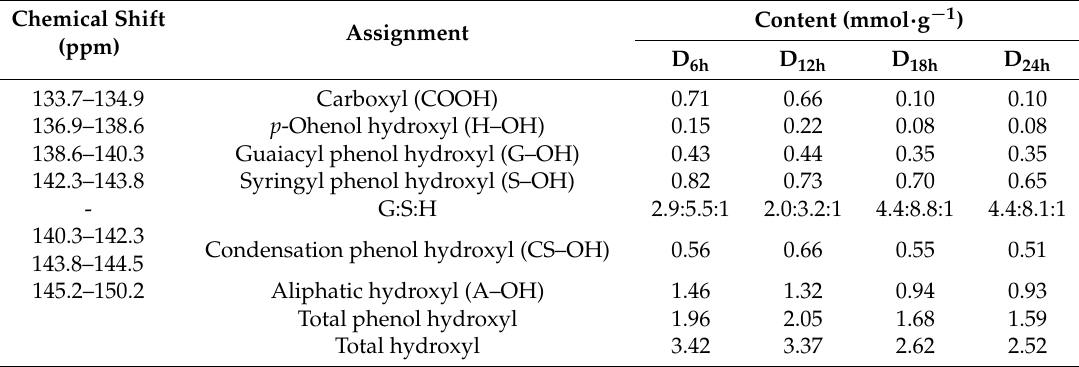
Figure 3. Quantification of different hydroxyl group (A–OH: aliphatic hydroxyl; G–OH: guaiacyl phenol hydroxyl; S–OH: syringyl phenol hydroxyl; H–OH: p -phenol hydroxyl; CS–OH: condensation phenol hydroxyl; COOH: carboxyl) contents (mmol/g) of DES-lignin samples (D 6h , D 12h , D 18h , D 24h ) extracted from willow by DES treatment at 120 ◦ C for 6, 12, 18, and 24 h as determined by 31 P NMR. Table 5. 31 P NMR analysis of DES-lignin samples (D 6h , D 12h , D 18h , D 24h ) extracted from willow by DES treatment at 120 ◦ C for 6, 12, 18, and 24 h.